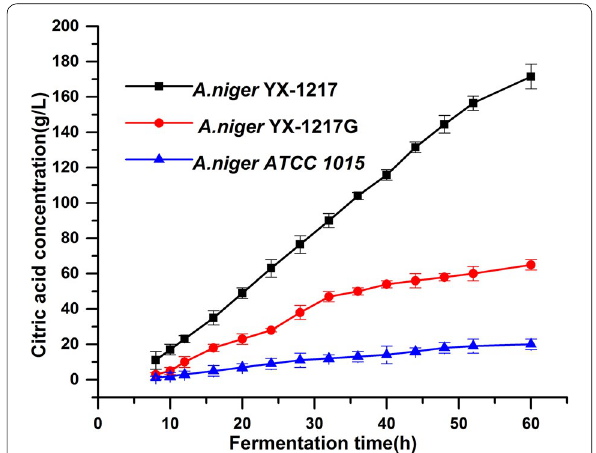
Fig. 1 Results of citric acid fermentation by the three A. niger strains. The curves indicate that the citric acid concentration of A. niger YX‑1217, YX‑1217G, and ATCC 1015 increased consistently with the fermentation